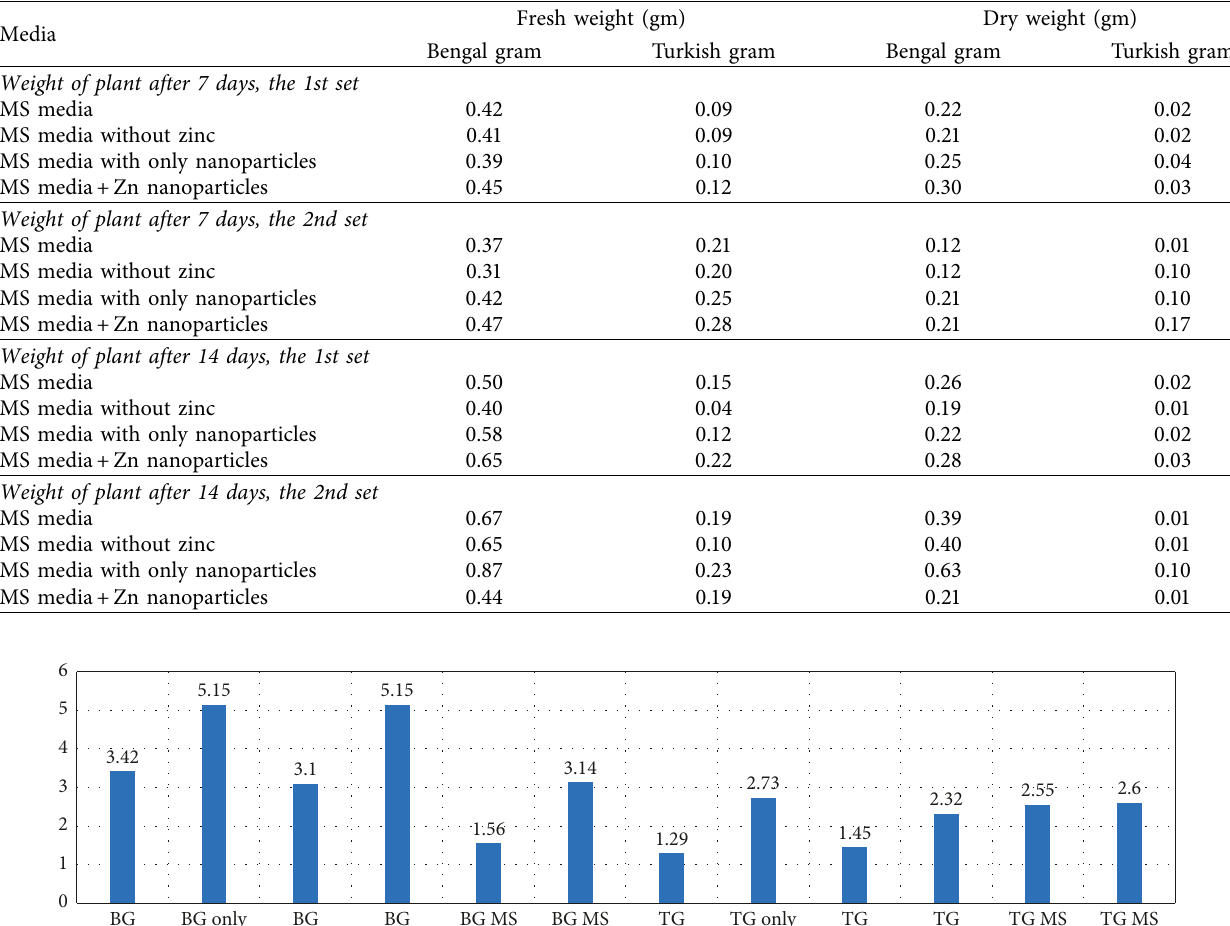
Table 4: Weight of plants after 7 and 14 days.